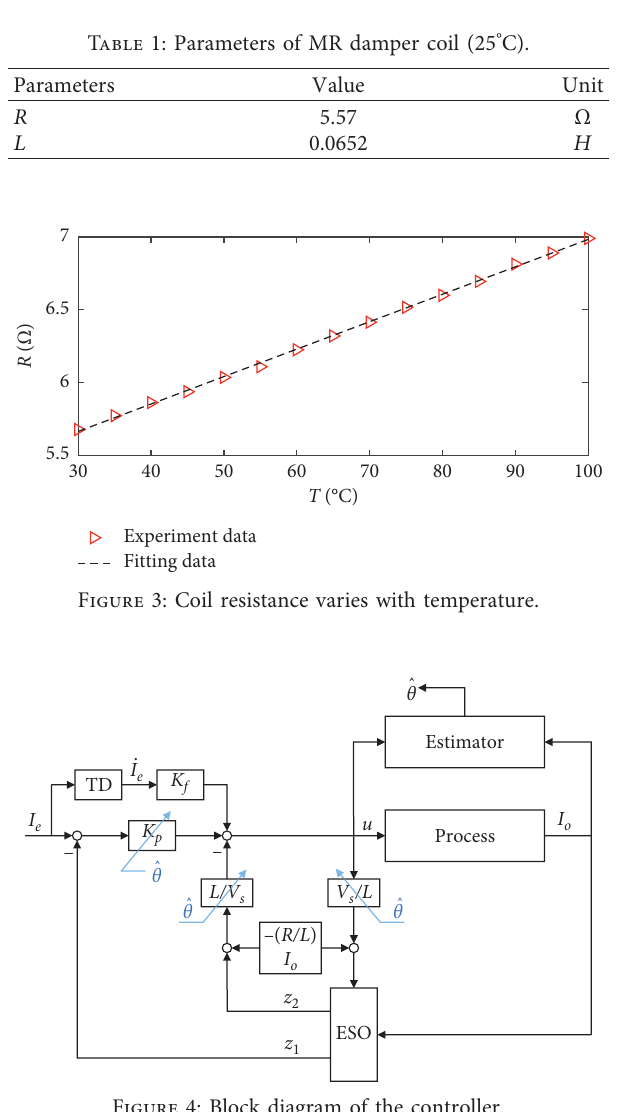
Figure 4: Block diagram of the